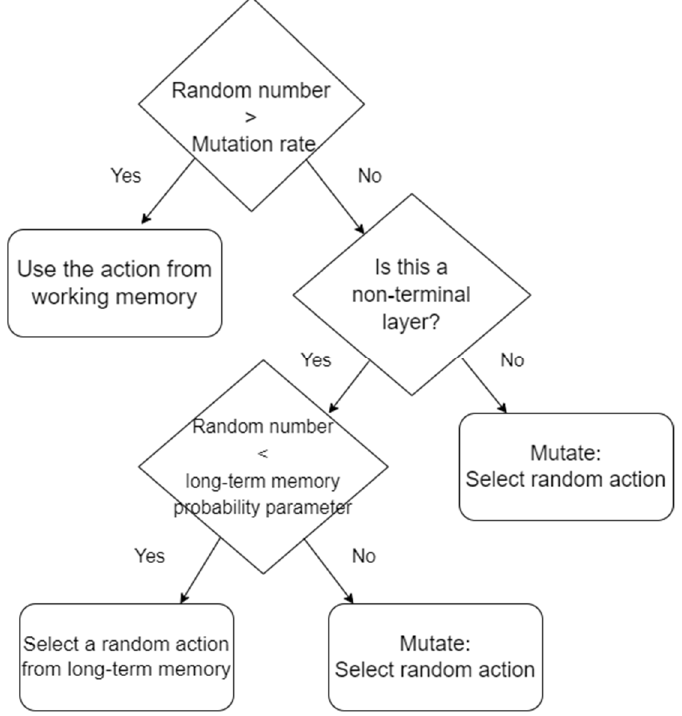
Figure 6. Action selection decision tree for the (1+1) EA. Starting at the root, the agent determines if the action should be mutated or selected from the working or long-term memory.